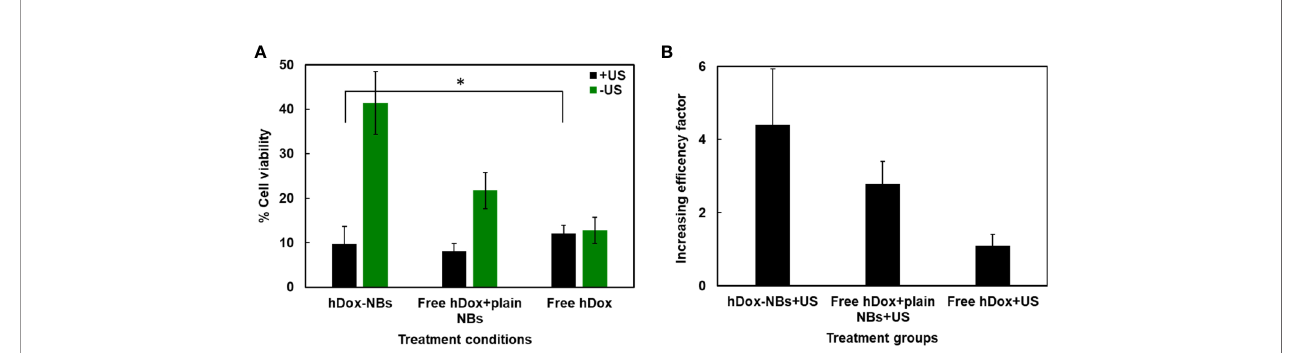
FIGURE 6 | Enhancement of Dox cytotoxicity in OVCAR-3 cells after treatment with hDox-NBs and ultrasound (+US). (A) Cell viability of OVCAR-3 cells for different treatments normalized to the untreated control; hDox-NBs have signi fi cantly lower toxicity compared to free hDox or free hDox with plain nanobubbles (NBs) when ultrasound is not present. With ultrasound application, the hDox-NBs lead to greater reduction in cell viability compared to free Dox and equivalent reduction compared to Dox co-injected with plain NBs. (B) An increasing ef fi cacy factor for each treatment group compared to the group without ultrasound (-US). All experiments were carried out in triplicate. Error bars represent standard deviation. Asterisk indicates signi fi cant difference at p <